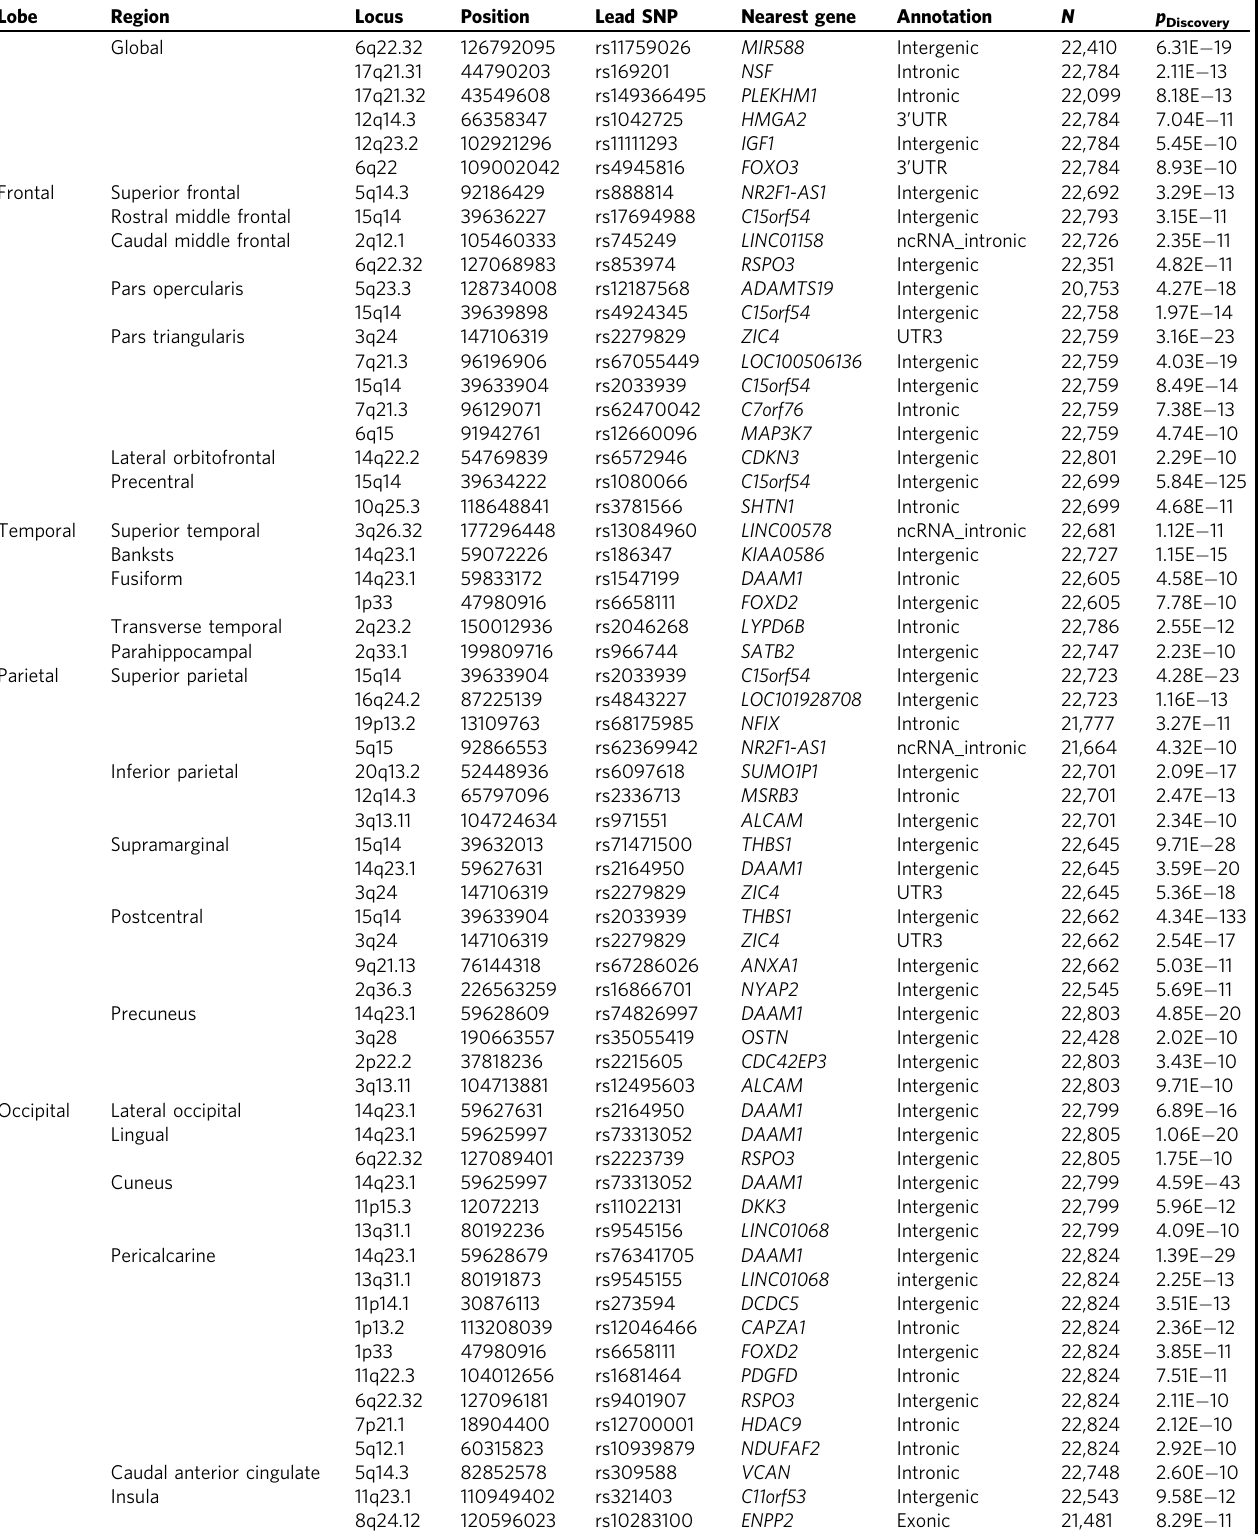
Table 3 Genome-wide signi fi cant associations ( p Discovery < 1.09 × 10 − 9 ) of global and regional CV. Lobe Region Locus Position Lead SNP Nearest gene